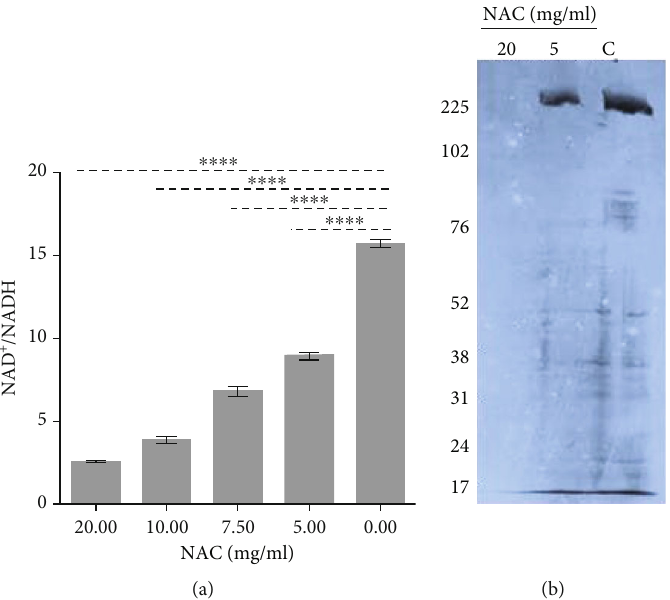
Figure 6: The e ff ects of NAC on bacterial oxidative stress and protein synthesis. (a) NAD + /NADH ratio for the 24h bio fi lm treated with NAC. The ratio decreases with the increase of NAC concentration indicating that NAC treatment causes an increase in oxidative stress in the cytosol of the bacteria. (b) 35 S labeling of proteins shows that NAC at 20mg/ml inhibits protein synthesis whereas at 5mg/ml does